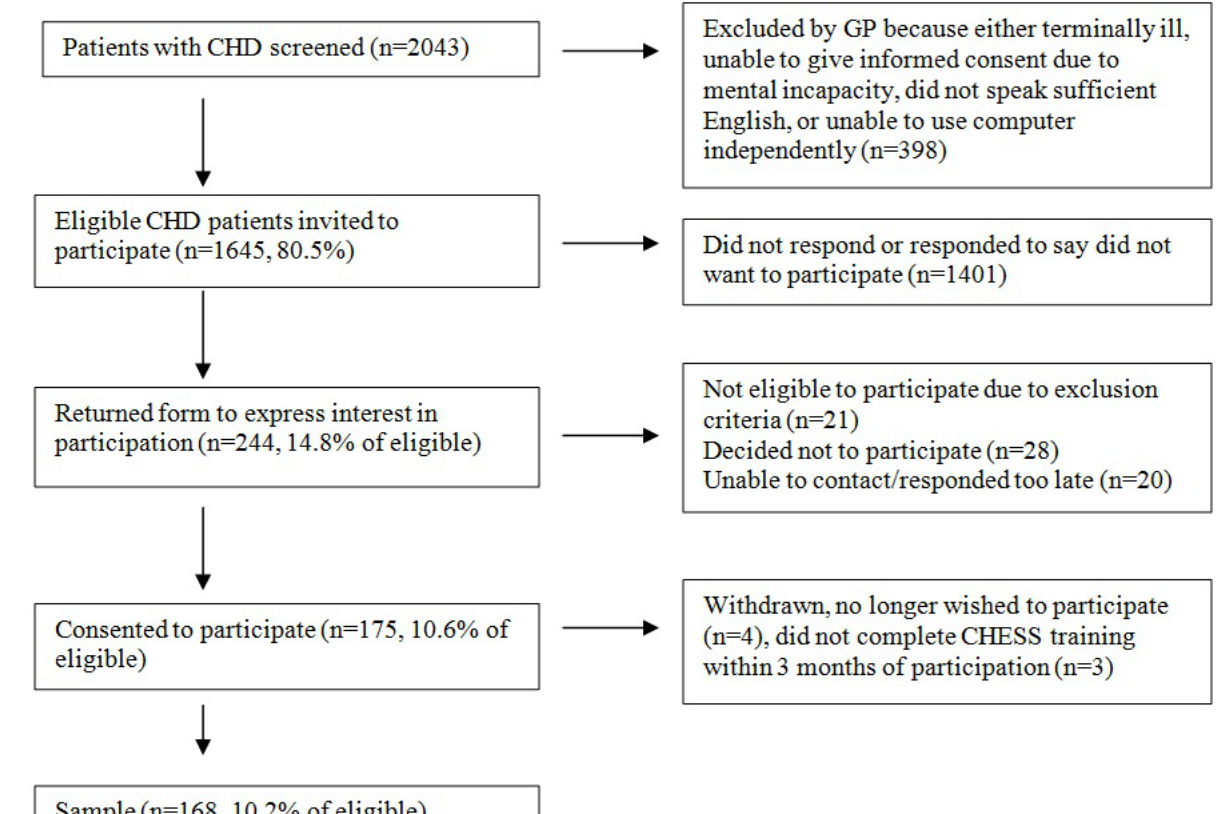
Figure 2. Sample